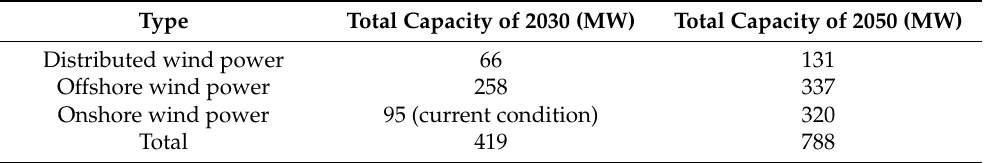
Table 12. The wind power